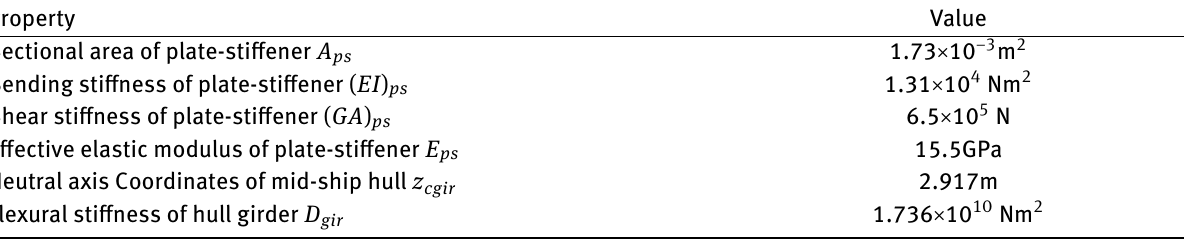
Table 4: Sectional properties of plate-stiffener combination and ship hull Property